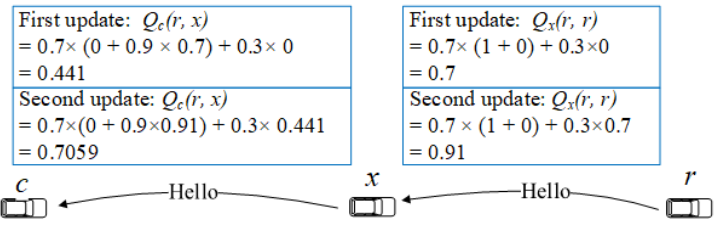
Figure 5. An example for Q -value update.